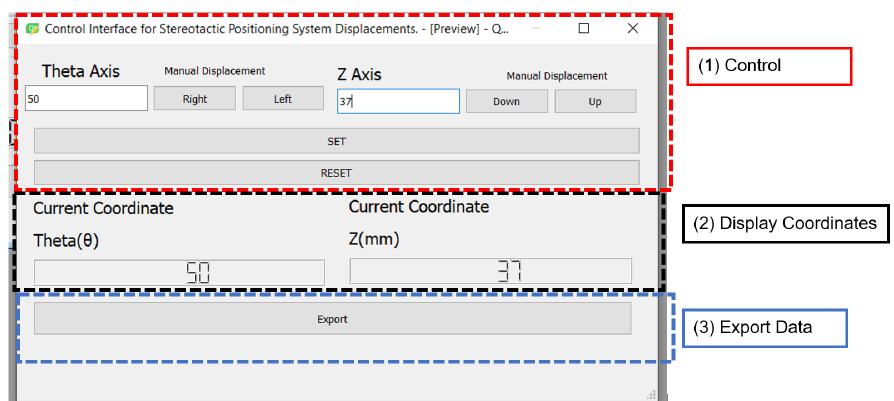
Figure 10. Graphical user interface implemented for preliminary tests of the stereotactic positioning system, showing the sections (1) control displacement, (2) display coordinates, and (3) data export.